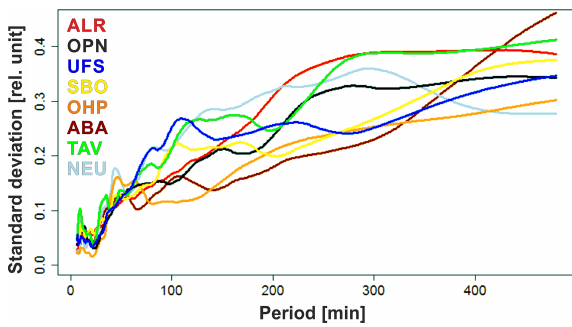
Figure 4. Standard deviation of the wavelet intensity for each period between 6 and 480min and for all